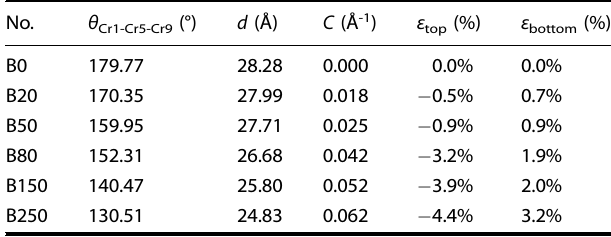
The symbol θ is the angle formed between the connected lines of Cr 1 -Cr 5 and Cr 5 -Cr 9 (Fig. 1c), and C is the curvature; ε top and ε bottom indicate the average in-plane strain of the top and bottom I layers across the nanoribbons,